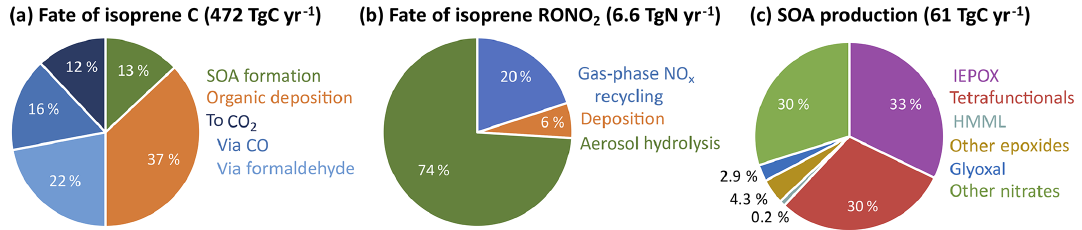
Figure 8. Accounting in the reduced Caltech isoprene mechanism (RCIM) of (a) isoprene carbon, (b) the fate of isoprene-derived organoni- trates (not including PANs), and (c) isoprene-derived SOA production. Values are global annual means from RCIM implemented in GEOS-